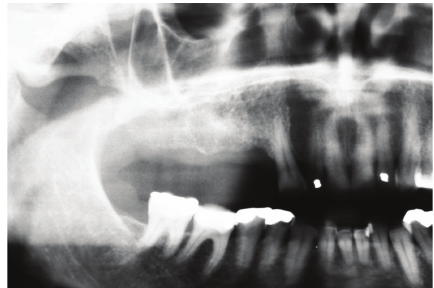
Figure 7: Radiograph showing new bone formation.